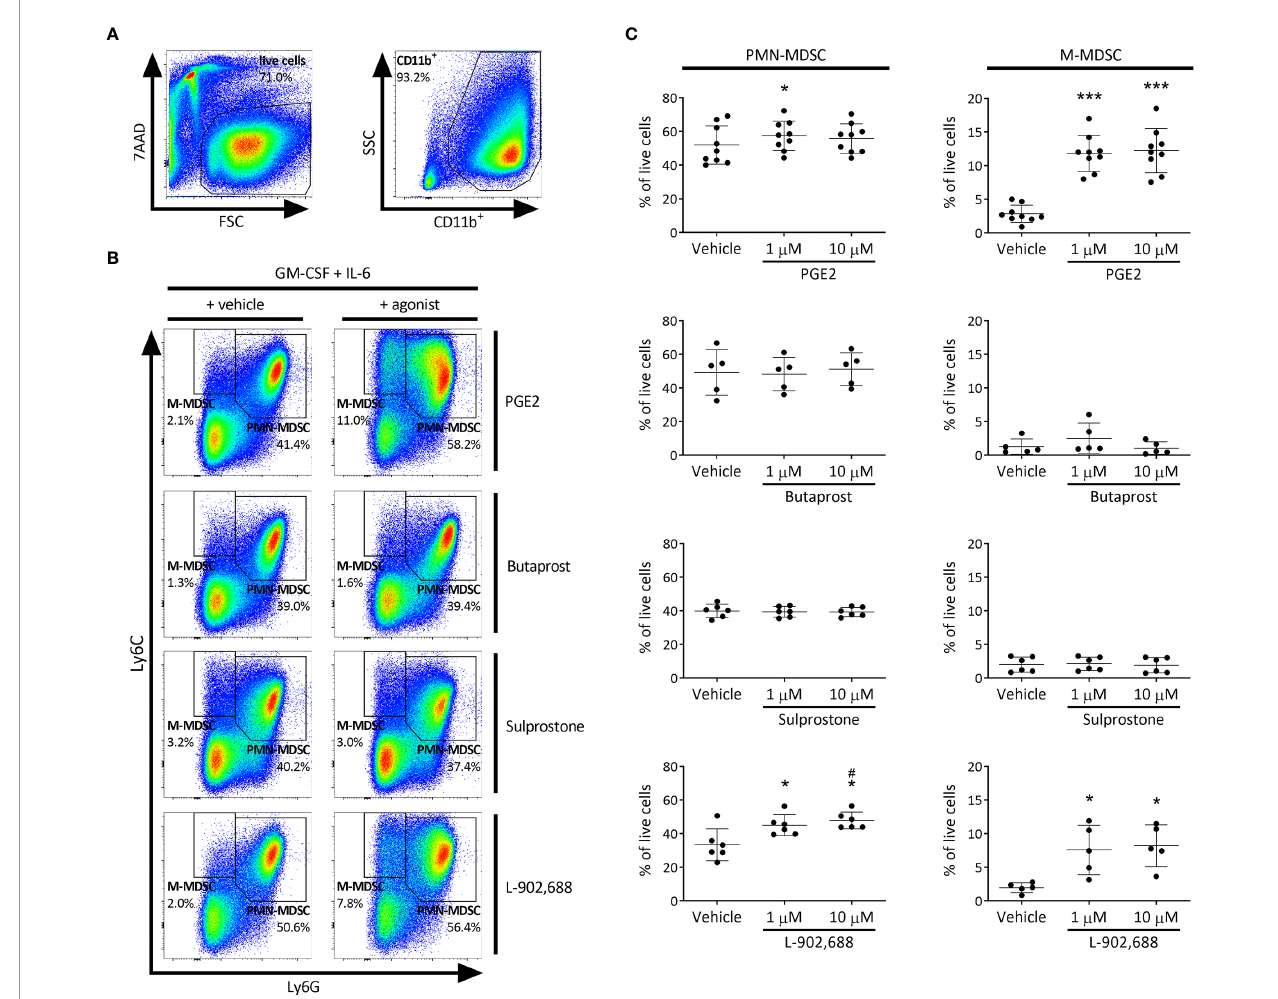
FIGURE 1 | The effect of PGE2 and EP receptor agonists on MDSC generation in murine bone marrow cells. Bone marrow cells isolated from the hind legs of 6- to 8-week-old female BALB/c mice were cultured in the presence of PGE2 or EP receptor agonists, including EP2 agonist Butaprost, dual EP1/EP3 agonist Sulprostone and EP4 agonist L-902,688 (1 or 10 µM) or their respective vehicles in combination with GM-CSF (20 ng/ml) and IL-6 (20 ng/ml) for 3 days. (A) Gating strategy of MDSC subtyping by fl ow cytometry. CD11b + cells were fi rst selected from live bone marrow cells before MDSCs were gated. (B) Representative MDSC gating of bone marrow cells cultured in either vehicle (left) or 10 µM agonist (right), where CD11b + Ly6G + Ly6C int and CD11b + Ly6G - Ly6C hi are de fi ned as PMN- and M-MDSCs, respectively. (C) Quantitative analysis of both PMN- (left) and M-MDSCs (right) were performed. Data shown as the percentage of live cells. Data was obtained from 5-9 independent experiments, with bone marrow cells from each mouse divided into the different conditions (vehicle, 1 or 10 µM) of each experiment, including 2 technical replicates per condition. Results of individual experiments and mean ± SD are shown. Statistical analysis was performed with repeated measures one-way ANOVA followed by Tukey ’ s multiple comparisons test. * p < 0.05, *** p < 0.001 compared with vehicle, # p < 0.05 compared to 1